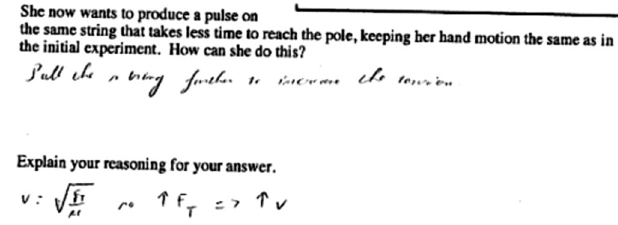
FIG. 1. Example student response to a predict-style question. “ [to make a pulse that takes less time to reach the pole, she should] pull the string further to increase the tension [because] p v ¼ ð T= μ Þ and ↑ F → ↑ v . ” T